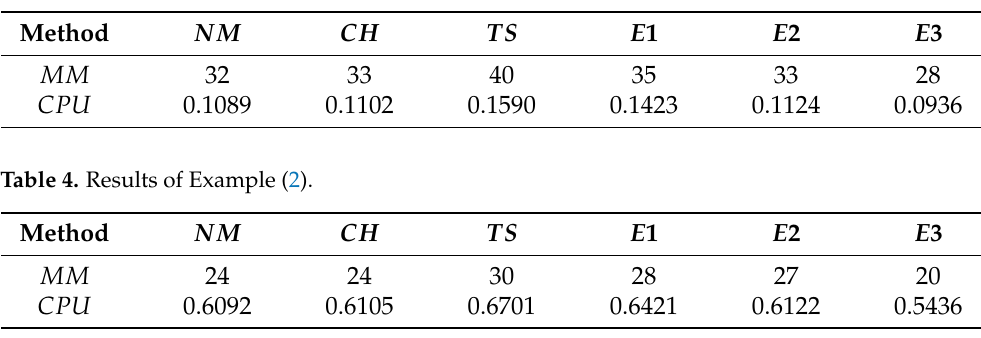
Figure 3. Representation of the ( a ) matrix and ( b ) inverse matrix for Example (3), respectively. Table 3. Results of Example (1).